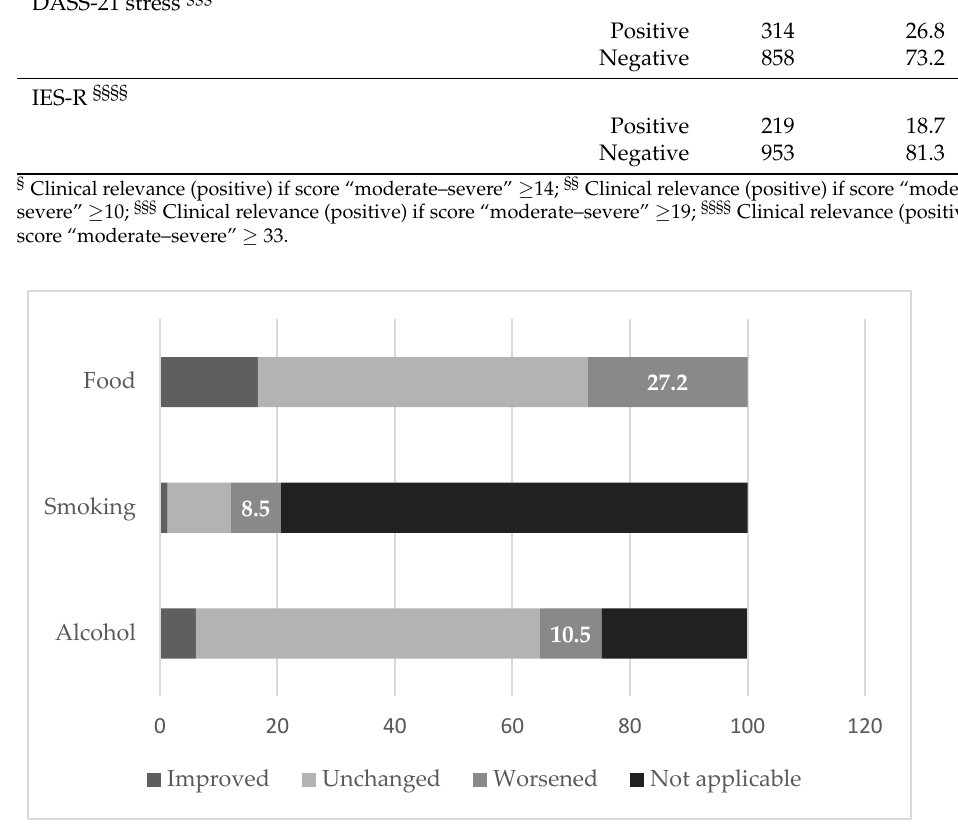
Figure 1. Changes in lifestyle. “Not applicable” refers to respondents who reported not to drink alcohol or to smoke.